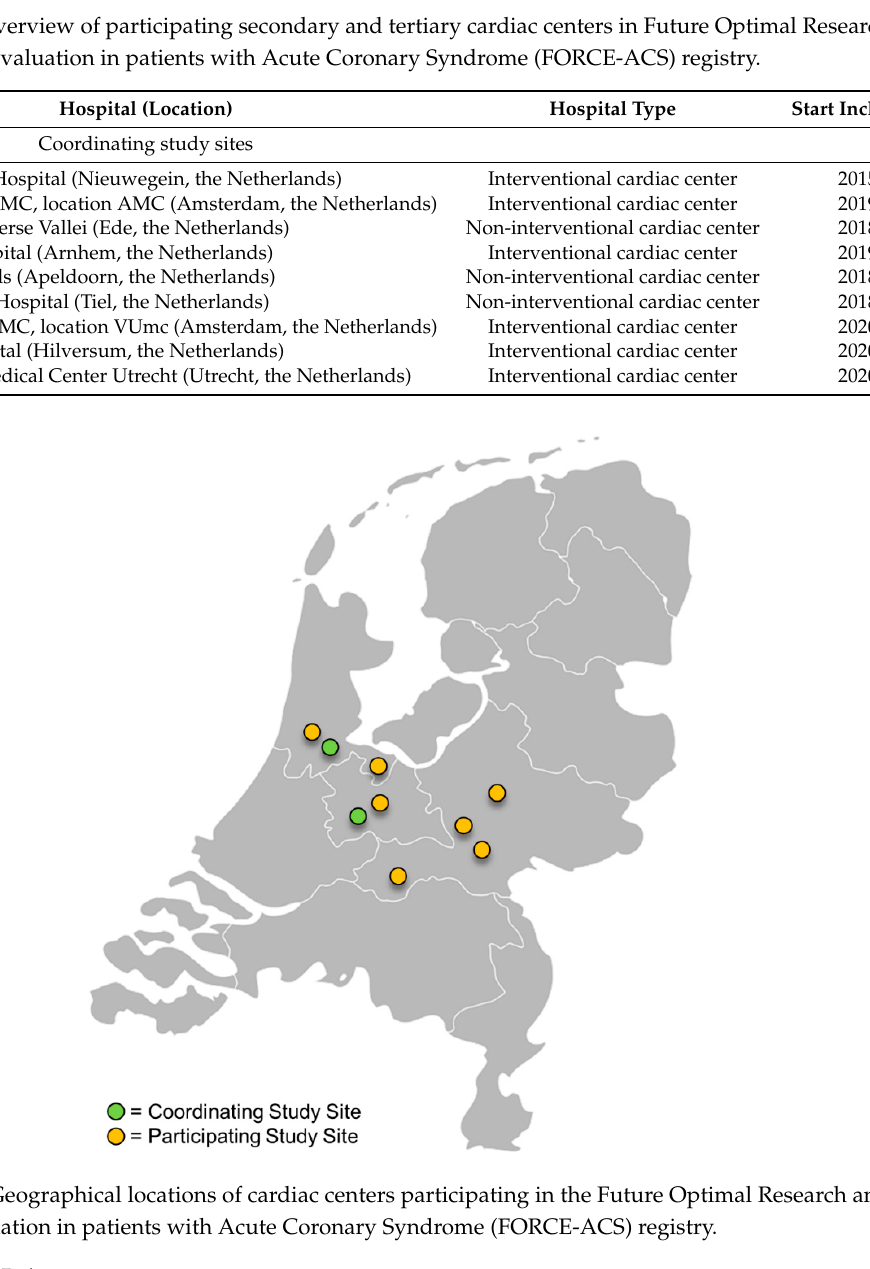
Table 1. Overview of participating secondary and tertiary cardiac centers in Future Optimal Research and Care Evaluation in patients with Acute Coronary Syndrome (FORCE-ACS) registry.